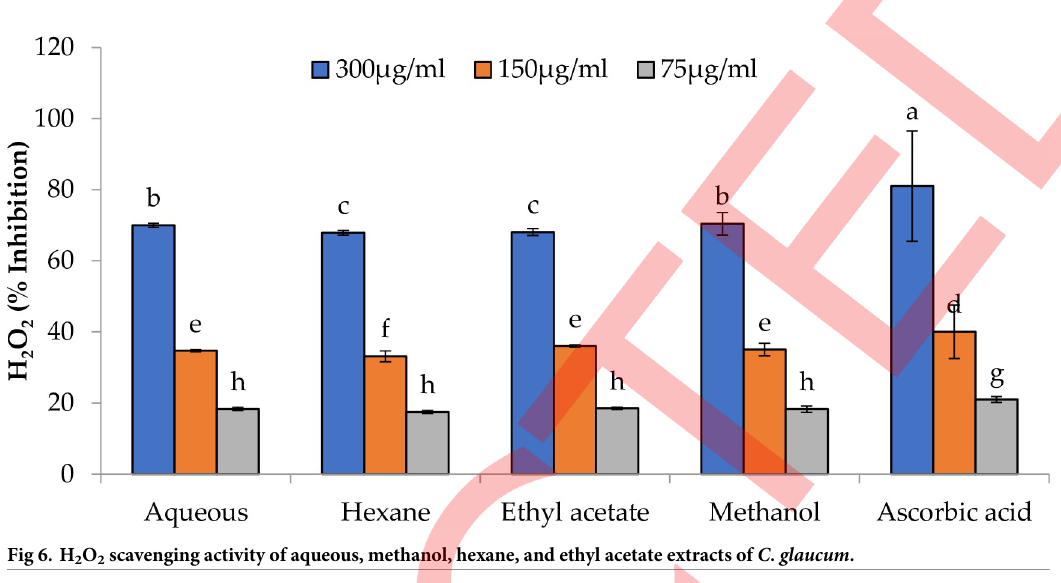
Fig 6. H 2 O 2 scavenging activity of aqueous, methanol, hexane, and ethyl acetate extracts of C . glaucum .